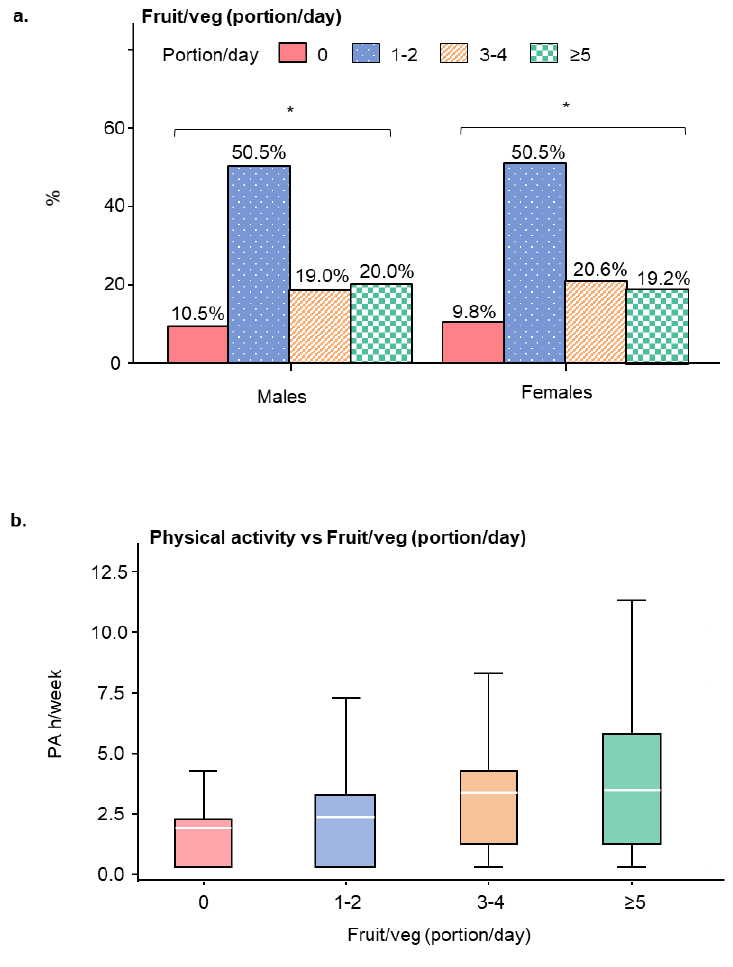
Figure 2. Daily average consumption of fruits and vegetables (portion/day) in participants and its relationship with the levels of physical activity. ( a ) Bar figure displaying the percentages of fruits and vegetables consumed daily by male and female students. ( b ) Relationship between the levels of physical activity and daily fruit and vegetables intake (portion/day). * p -value 0.0050, odds ratio OR 3.96 (1.514, 10.374). Data are represented as mean (standard deviation (SD)).